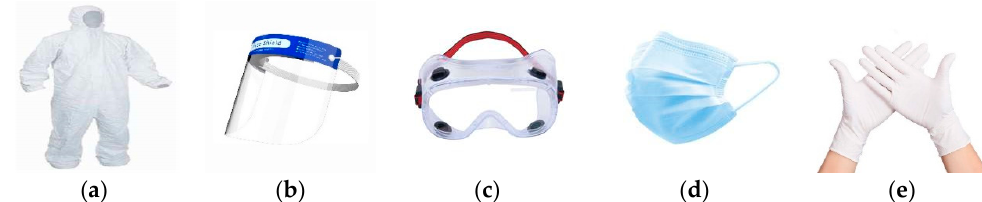
9 of 17 Figure 5. ME ‐ YOLO network structure. 4. Experiments and Results 4.1. Dataset and Expansion Method As there is no relevant large dataset of medical personal protective equipment avail ‐ able, the dataset used in this article was derived from images screened in CPPE ‐ 5 [31] as well as from our collection of medical personal protective equipment images, ultimately obtaining 2500 images with five categories—suit, mask, glove, face shield, and goggle— as shown in Figure 6, containing different scenarios as well as small targets small targets and obscured targets. The dataset was then expanded to 5000 images by panning, rotating,